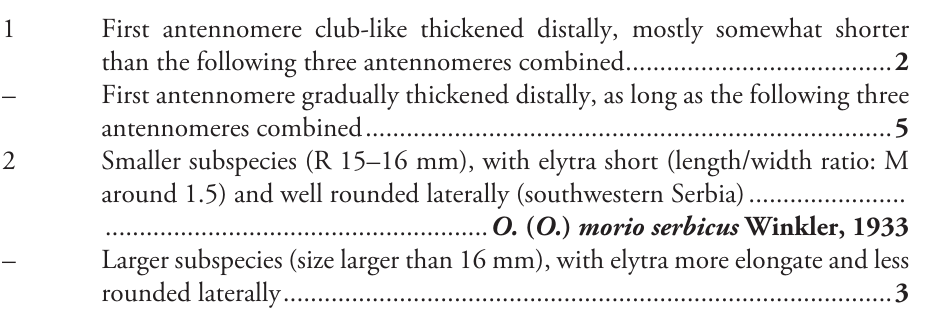
Lateral pronotal margins somewhat narrowed or almost parallel basally, size smaller (R 15–20 mm), elytral striae more impressed, elytra narrower [sub- First antennomere club-like thickened distally, mostly somewhat shorter than the following three antennomeres combined (northwestern Montenegro) .... First antennomere gradually thickened distally, as long as the following three Size larger (R 20 mm), pronotum anteriorly stronger widened, head propor- tionally smaller, with longer antennae (western and southwestern Montene-